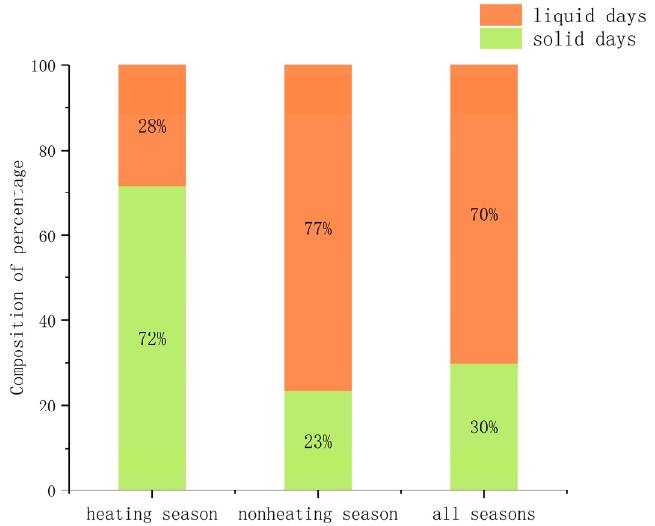
Figure 6. Liquid and solid source analysis for the heating season, nonheating season and whole year. Table 2. Statistics of ρ (EBC370)/ ρ